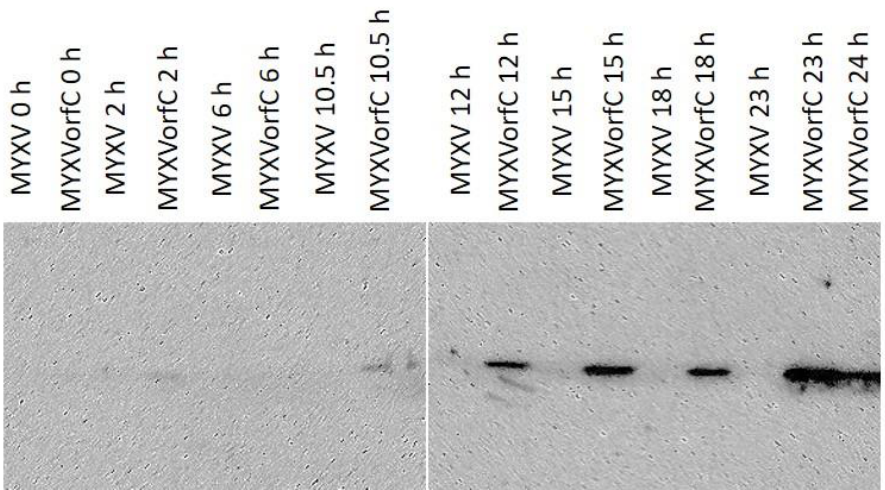
Figure 5. Western immunoblot. Hemagglutinin-tagged orfC was detected in RK-13 cell lysates by 12 hpi (moi = 0.5). Data were repeatable ( n = 3).